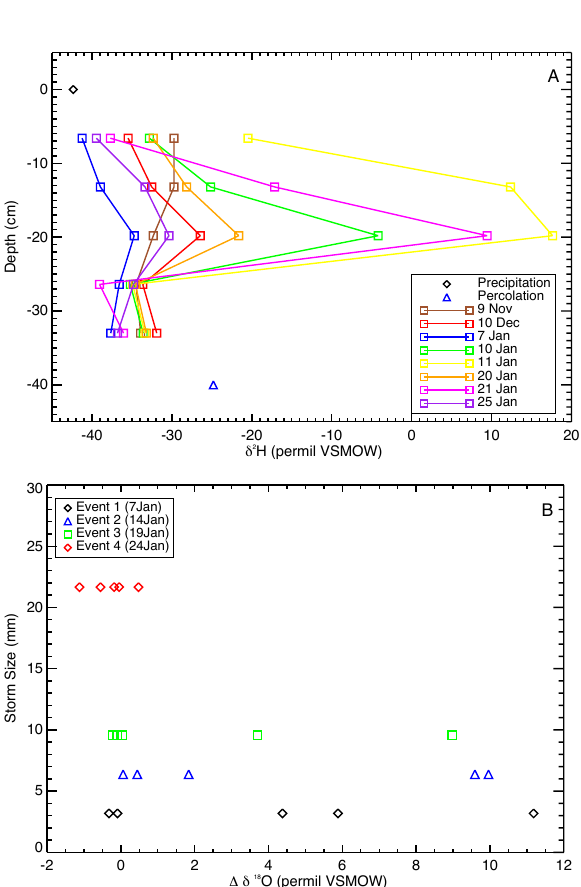
Fig. 6. Several isotopes profiles in the lysimeter measured during study period (A); 1 18 O in several precipitation events